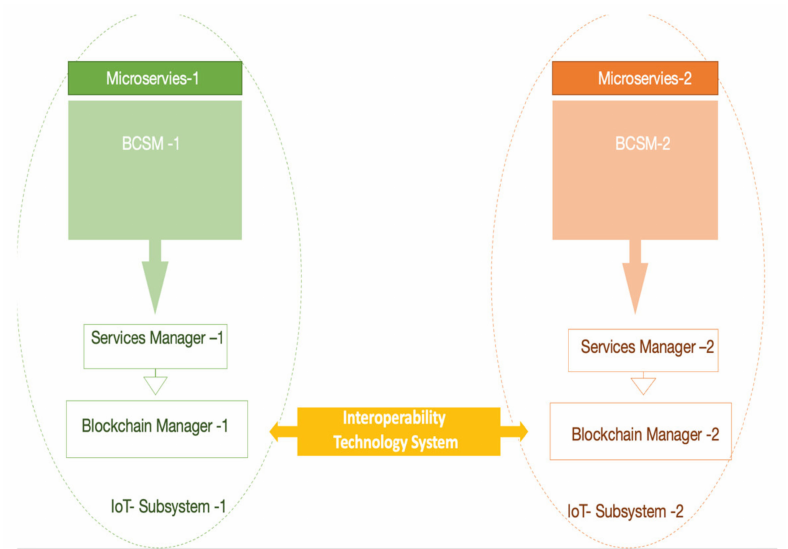
Figure 2. High-level architecture of the proposed solution.